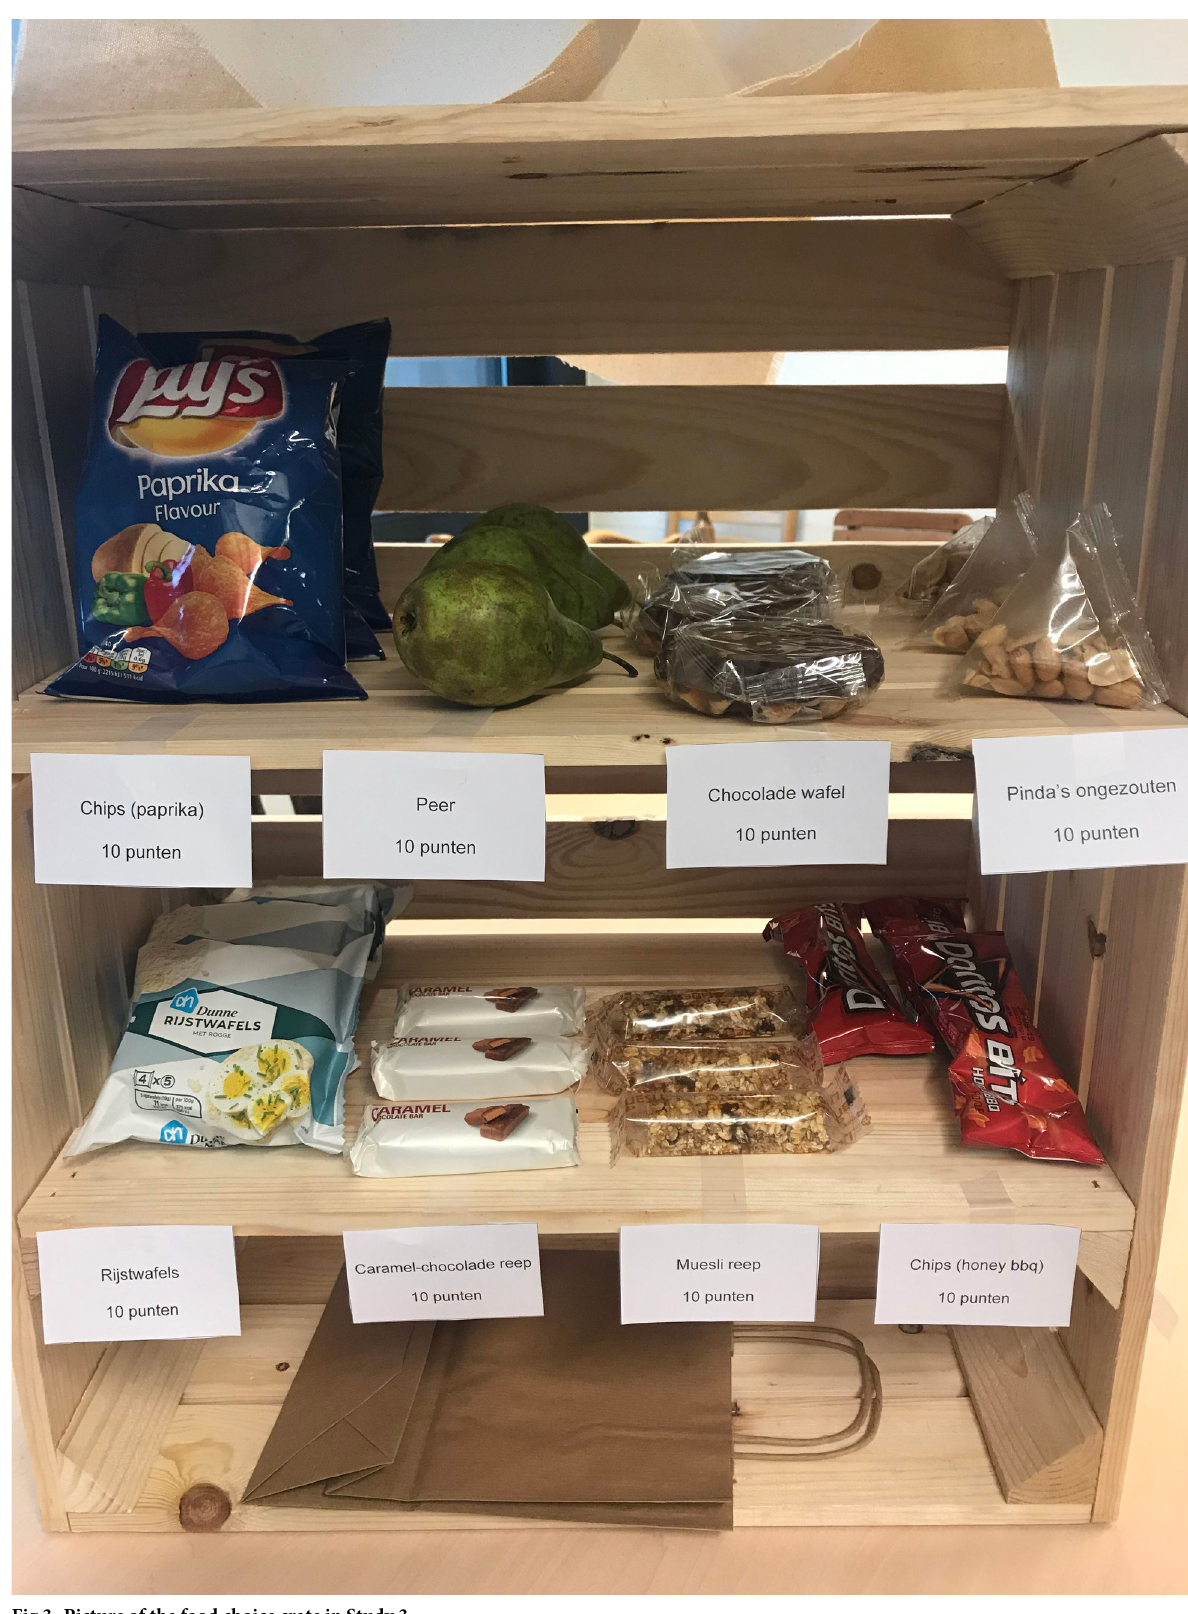
Fig 3. Picture of the food choice crate in Study 3.